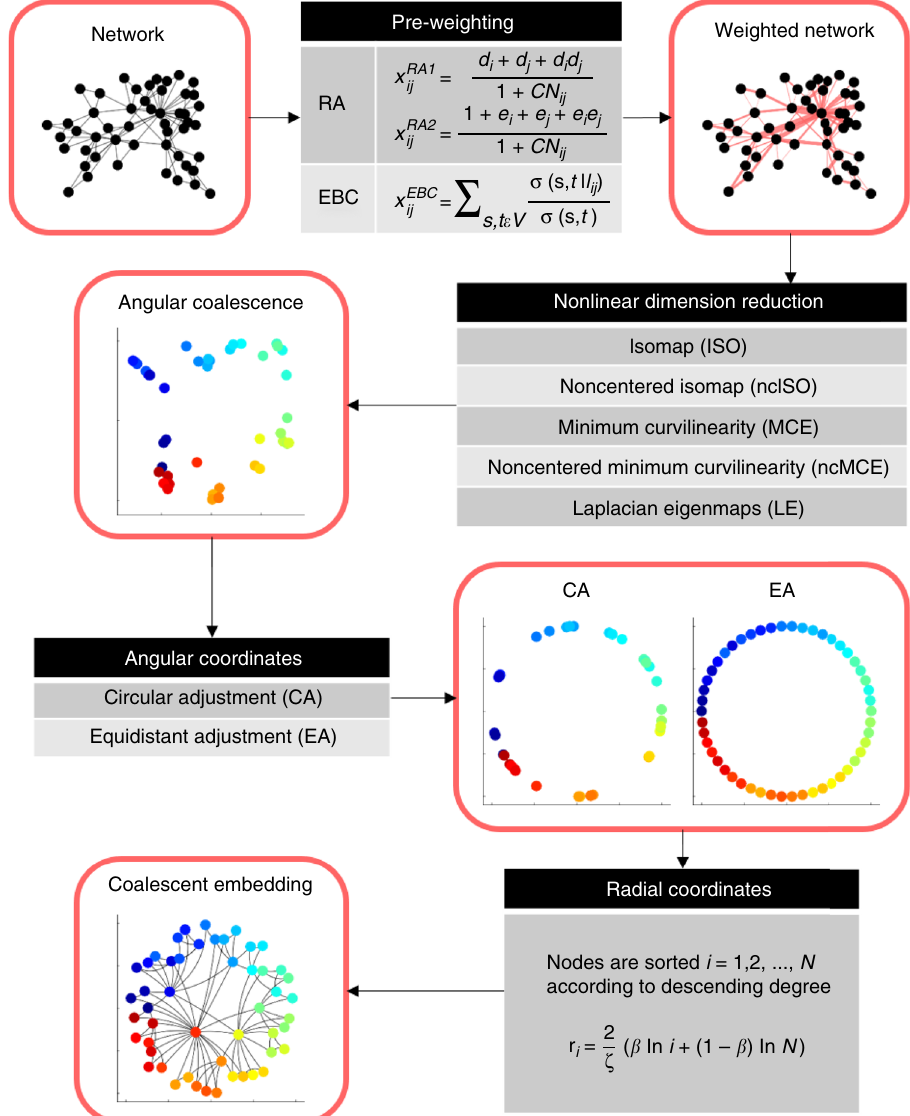
Fig. 2 Flow chart of the coalescent embedding algorithm. The algorithmic steps (grayscale squares) and the intermediate input/output (rounded red squares) of the coalescent embedding algorithm are illustrated. Each algorithmic step reports all the possible variants. The example network has been generated by the PSO model with parameters N = 50, m = 2, T = 0.1, γ = 2.5. We applied the RA 1 pre-weighting rule and the ISO dimension reduction technique. The colors of the embedded nodes are assigned according to their angular coordinates in the original PSO network. Description of the variables in the mathematical formulas: x ij value of ( i , j ) link in adjacency matrix x ; d i degree of node i ; e i external degree of node i (links neither to CN ij nor to j ); CN ij (cid:1) (cid:1)(cid:3) (cid:4) common neighbors of nodes i and j ; V set of nodes; s , t any combination of network nodes in V ; σ ( s , t ) number of shortest paths ( s , t ); σ s ; t l ij number of ffiffiffiffiffiffiffi p (cid:2) K shortest paths ( s , t ) through link l ij ; N number of nodes; ζ ¼ , we set ζ = 1; K curvature of the hyperbolic space; β ¼ 1 γ (cid:2) popularity fading parameter; γ 1 exponent of power-law degree distribution. Details on each step are provided in the respective “ Methods ”